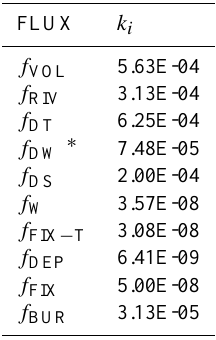
Table C1. Flux constants ( k i ) for reservoir model